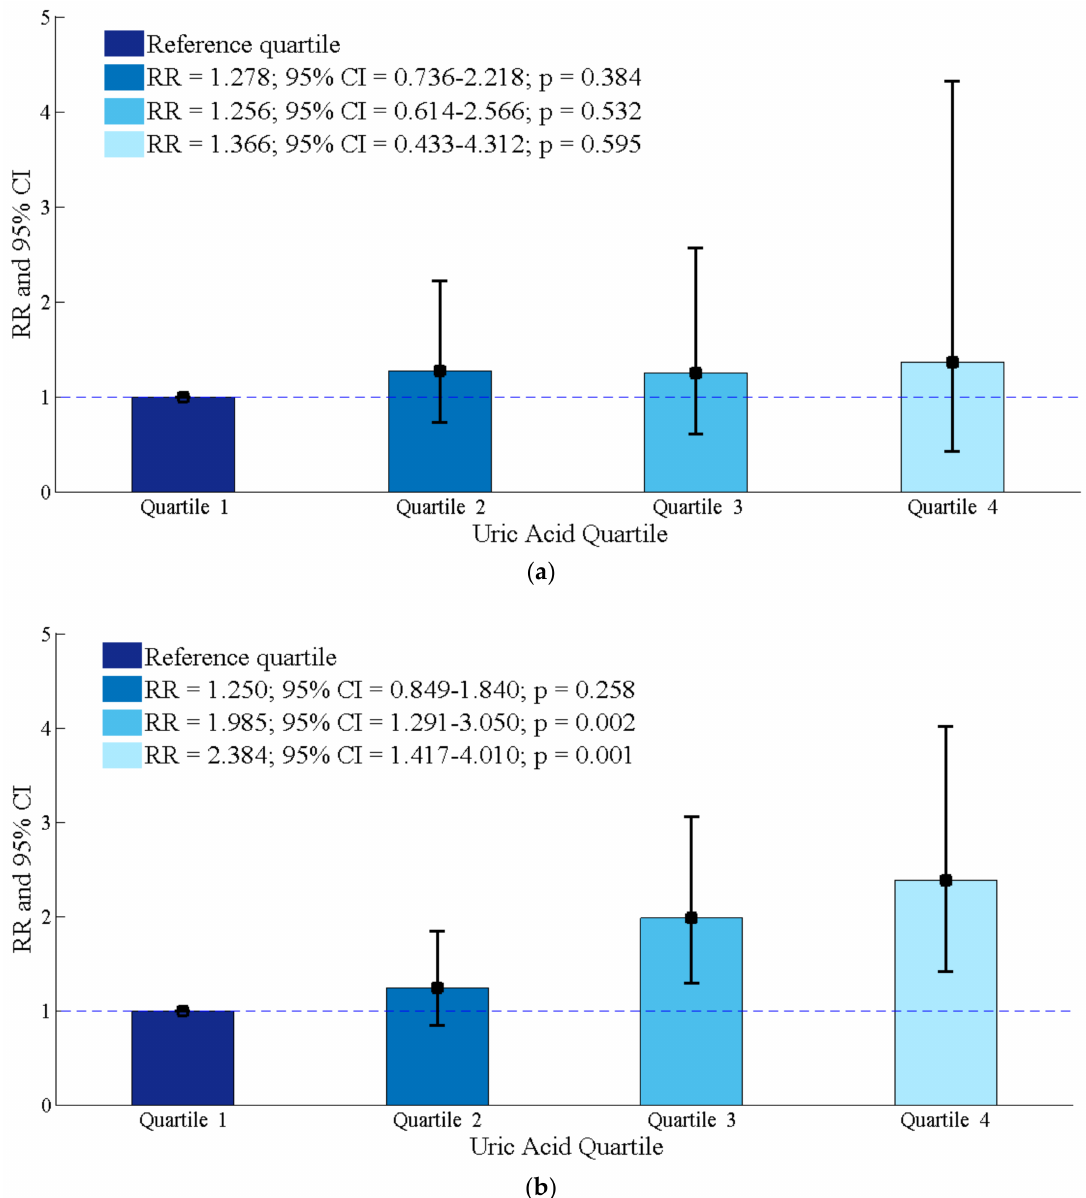
Figure 1. Results of the association between serum uric acid and incident prediabetes in older (age ≥ 48 years old) and younger (age < 48 years old) females. ( a ) Females aged < 48 years old; ( b ) Females aged ≥ 48 years